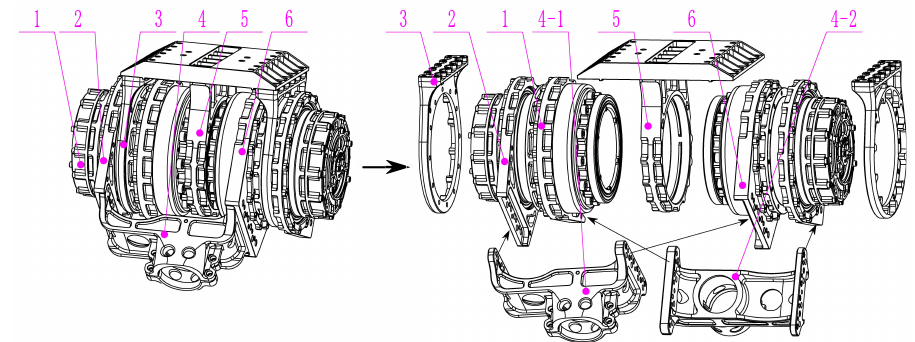
Figure 4. Highly integrated design of driver module. 1. Driving module, 2. driving flange, 3. side support, 4. output U-frame, 5. main support pedestal, 6. ancillary shoring